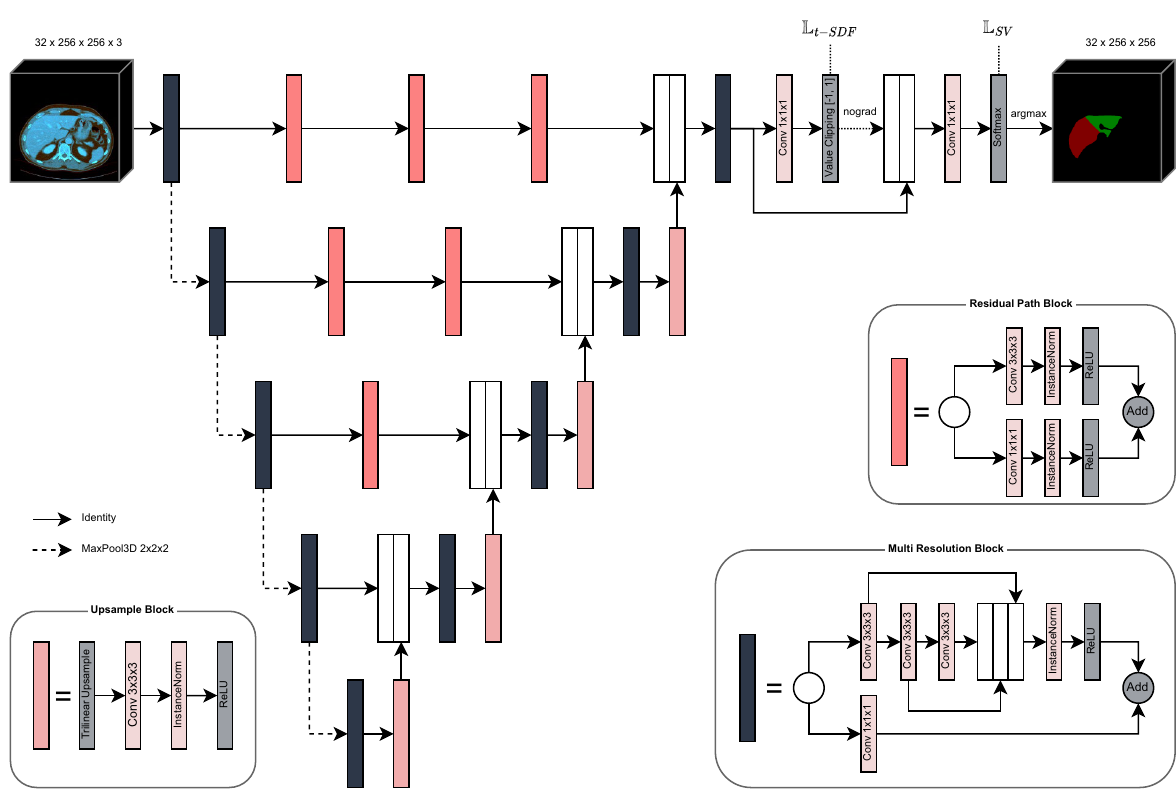
Figure 1. Architecture of the Multi-Resolution U-Net for liver lobe classification with auxiliary truncated Signed Distance Field (t-SDF) regression.